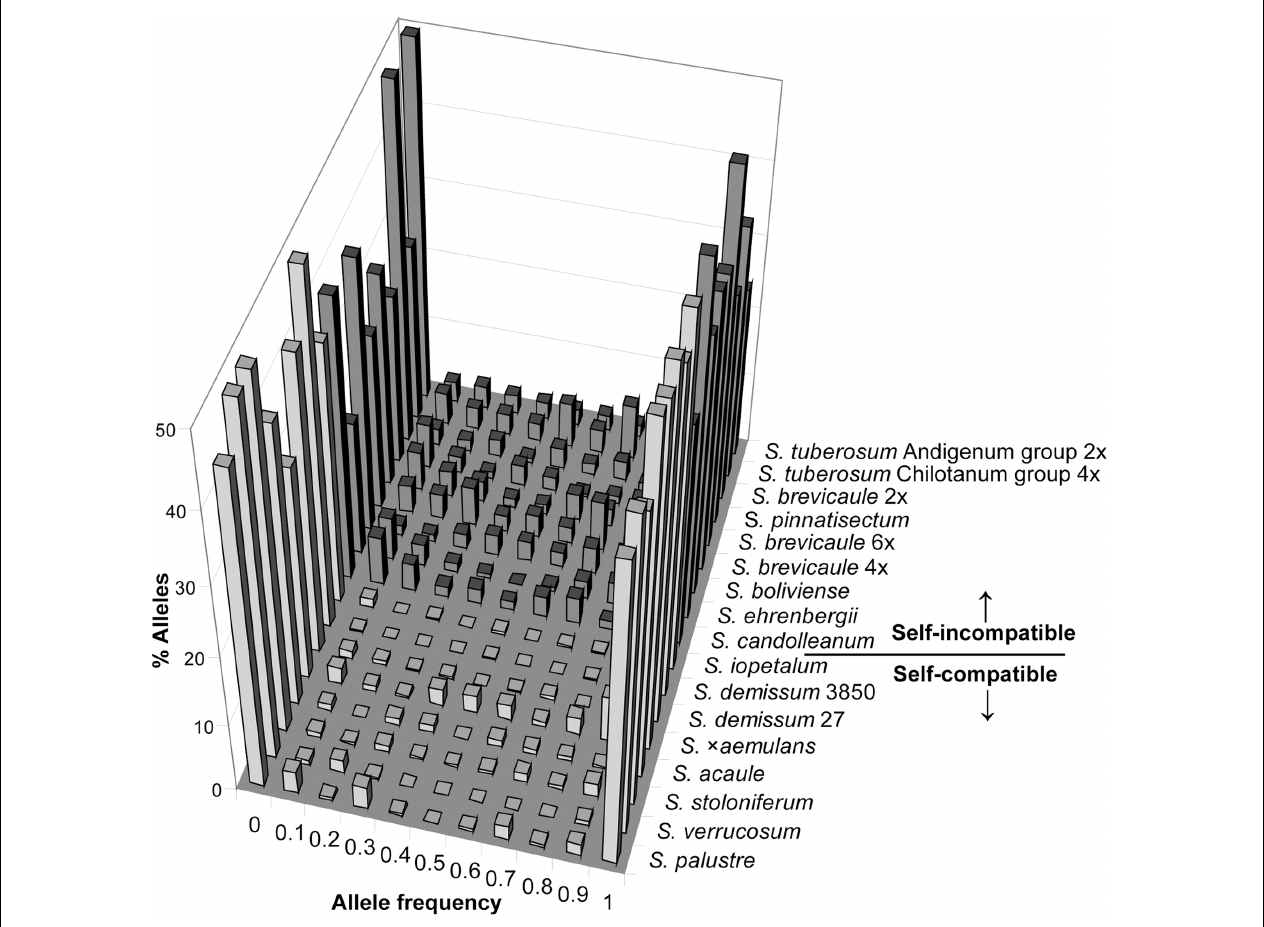
FIGURE 5 | AFLP allele frequency distributions grouped by self-compatible and self-incompatible species. Table 1 lists accessions and variant accession